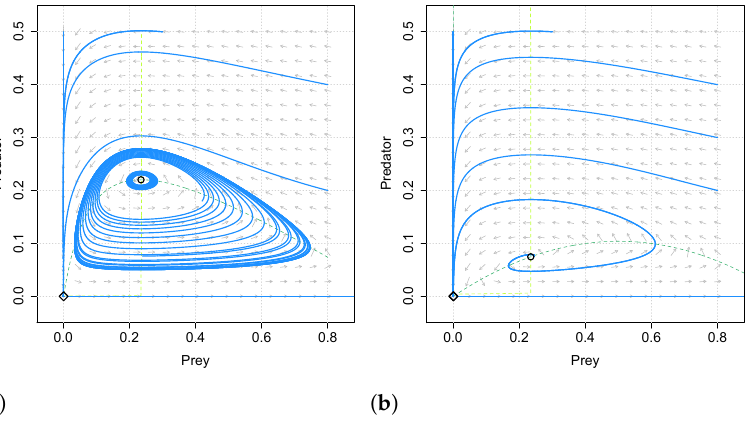
Figure 4. Dynamic behaviors with r = 0.5, n = 0.10375, K = 1, m = 0.001, q = 1.2, p = 0.175 and c = 0.041125. ( a ) Phase portrait for system (13). ( b ) Phase portrait for system